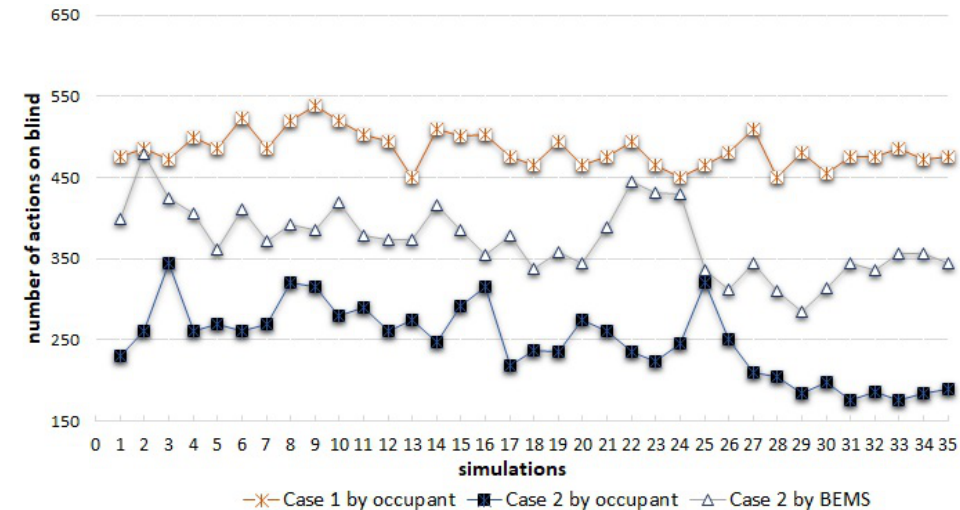
Figure 13. Number of actions of blinds closing for Cases 1 and 2.